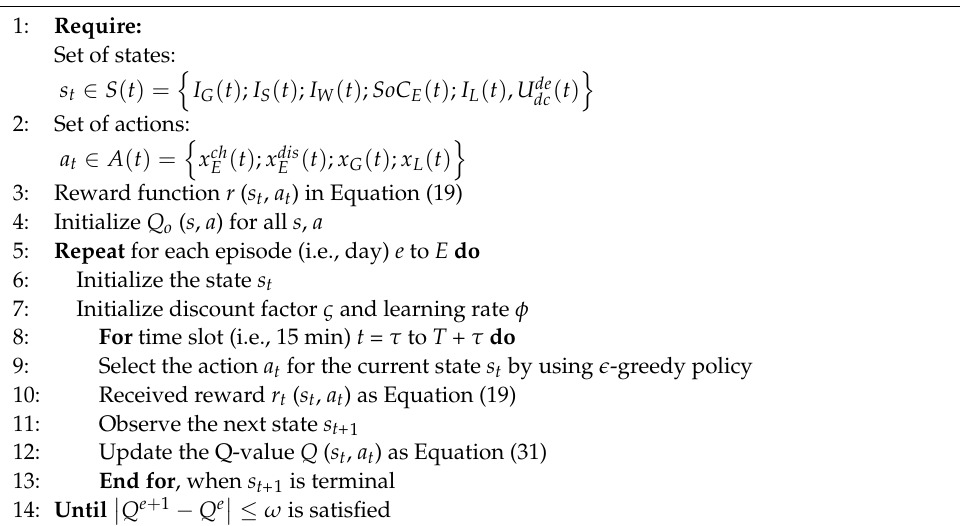
Algorithm 1: DQN-based MPC